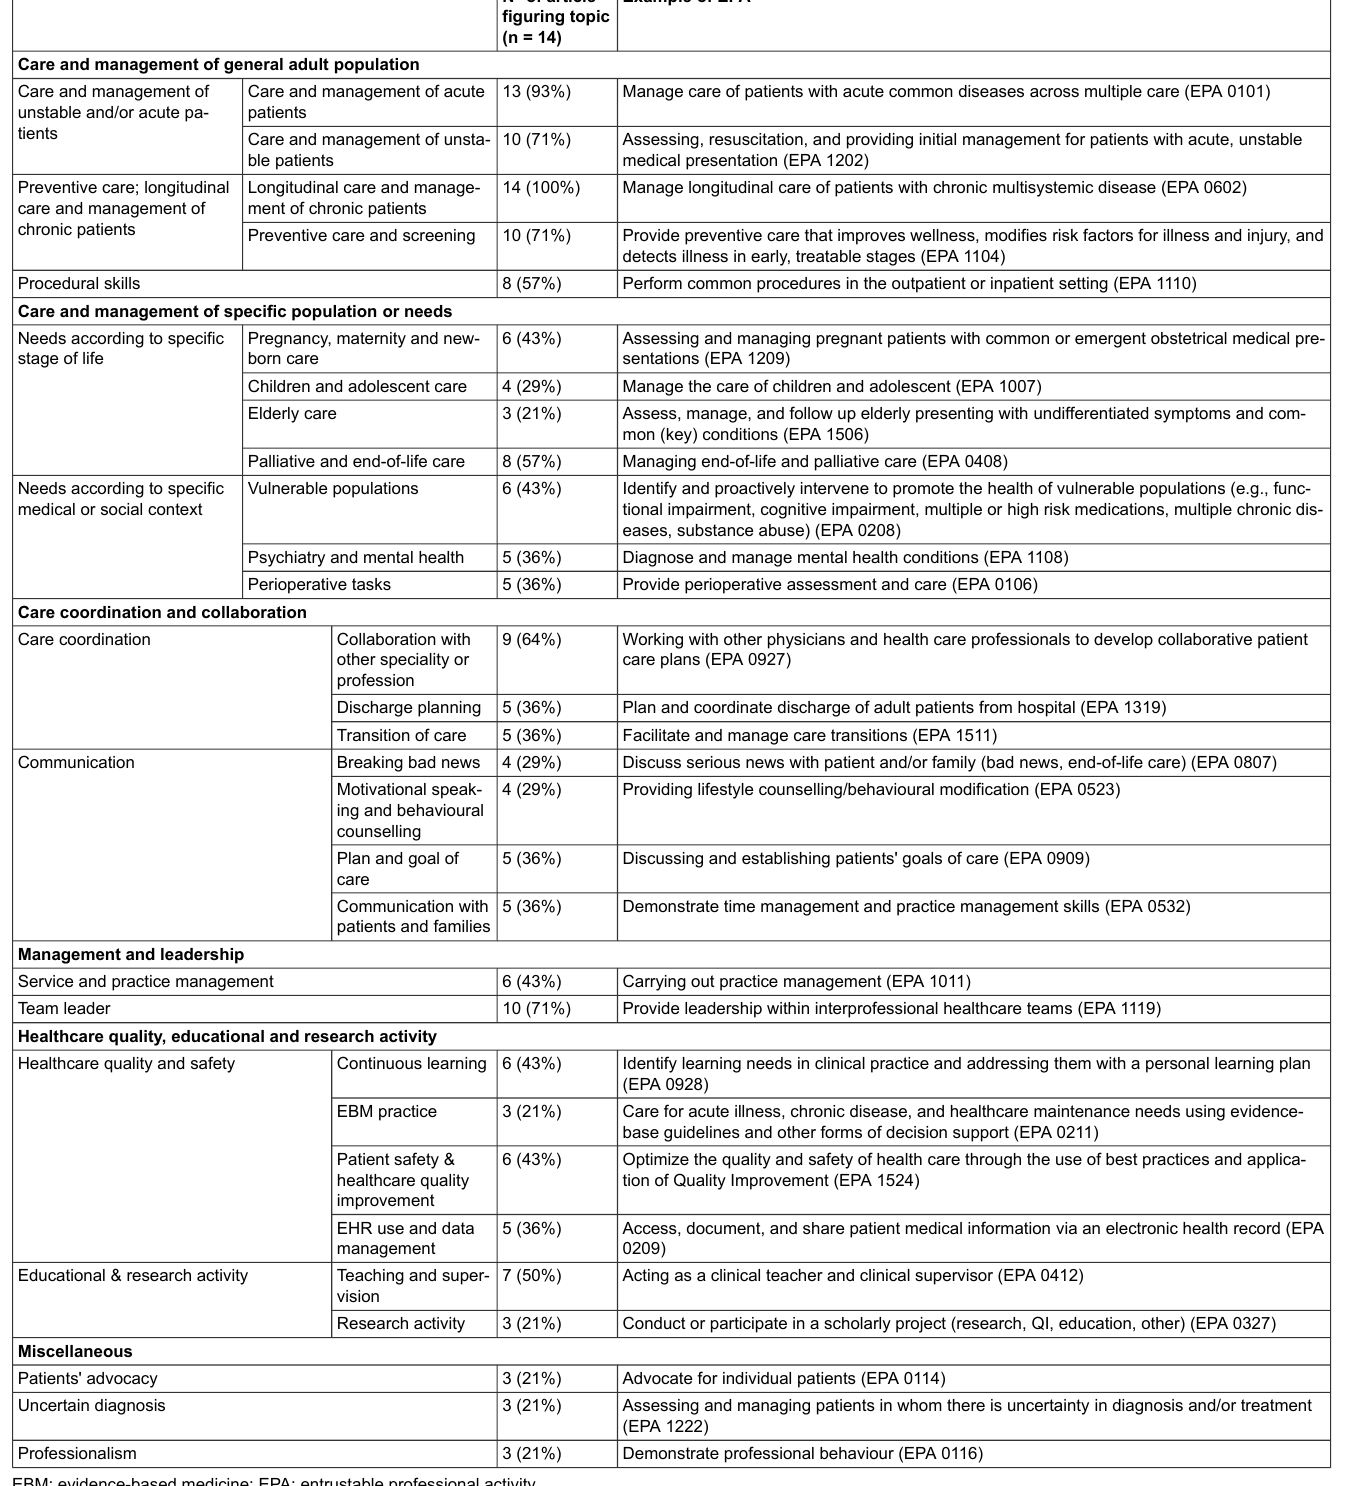
N° of article Example of figuring topic (n = 14)